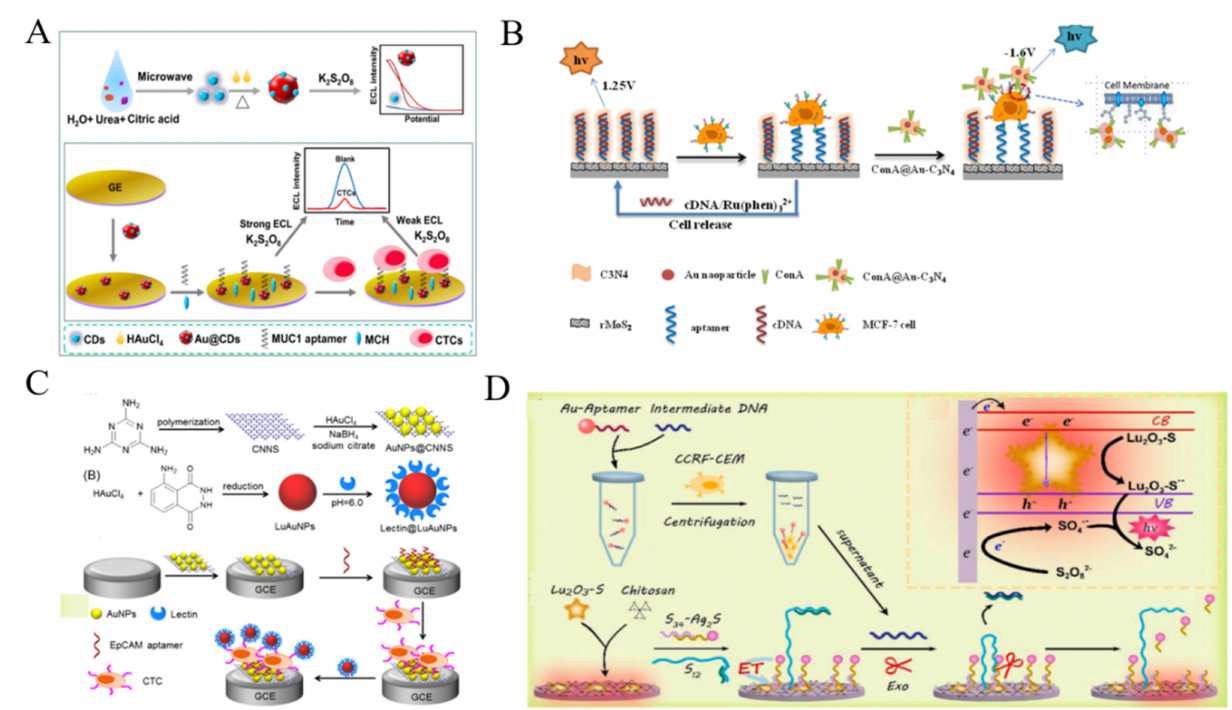
Figure 16. ( A ) Schematic representation of synthesis protocol and structural model of Au@CDs and principle of the Au@CDs-based ECL cytosensor for CTCs detection [252]. Copyright 2020 Elsevier B.V. ( B ) Schematic illustration of ECL biosensor for carbohydrate expression on cell surface based on ConA-modified Au-C 3 N 4 [255]. Copyright 2015 American Chemical Society. ( C ) Schematic representation of fabrication of cathodic probe AuNPs@CNNS and anodic probe lectin@LuAuNPs, and dual-potential ratiometric ECL strategy for detection ofCTCs [256]. Copyright 2016 Elsevier B.V. ( D ) Schematic representation of the Lu 2 O 3 -S nanosheets-based EL cytosensor [257]. Copyright 2021 Elsevier